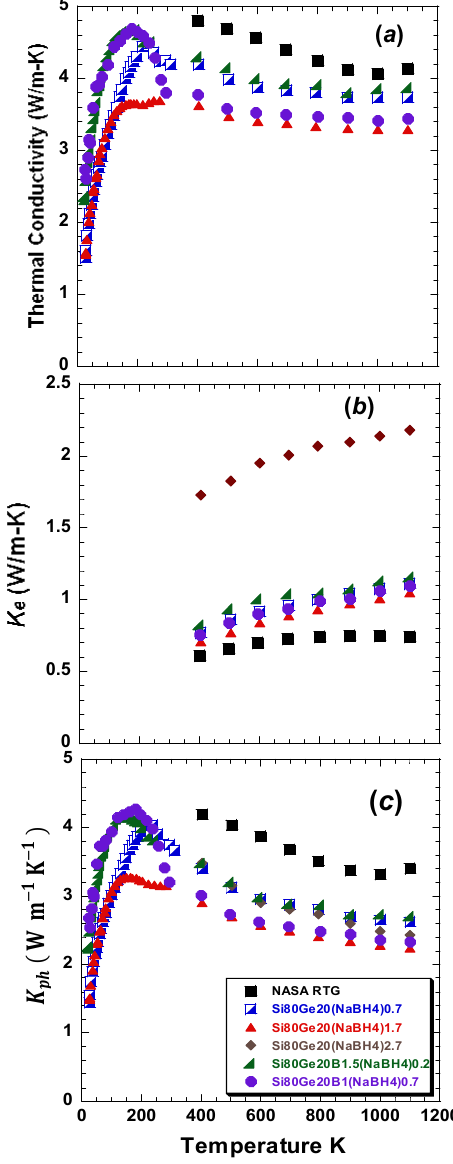
Figure 5. Temperature dependence of ( a ) the total thermal conductivity; ( b ) the electronic thermal conductivity; and ( c ) the lattice thermal